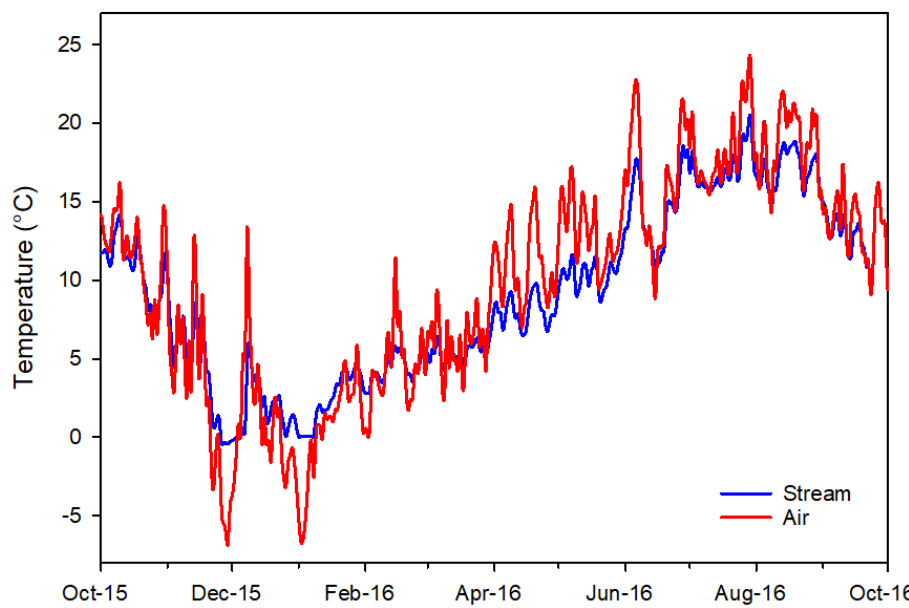
Figure 7. Daily averaged stream and riparian air temperature for all sensors in the 800 m reach of 15-MC.